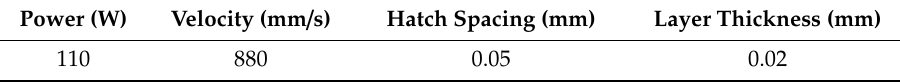
Table 1. Additive manufacturing (AM) processing parameters for EOS